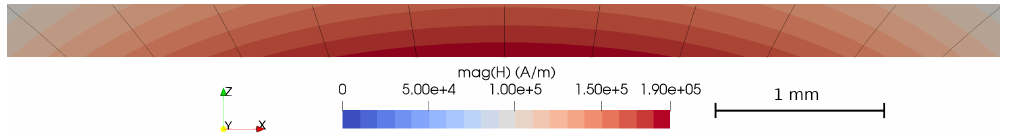
Figure 8. The calculated magnetic field in the center part of the microchannel. The peak values of the field reach the value of H = 180kA · m − 1 . The lines of induction are also